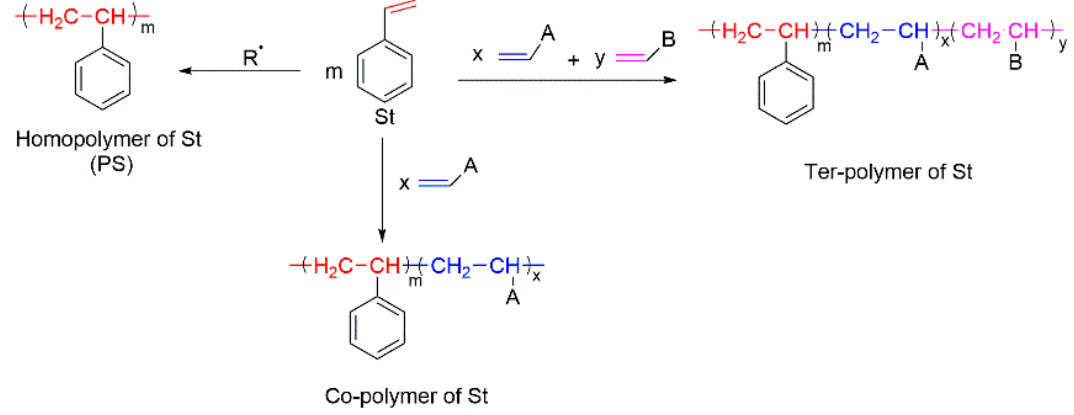
Figure 1. A general scheme of homo -, co-, and ter- polymerisation of styrene (R: is an initiator).